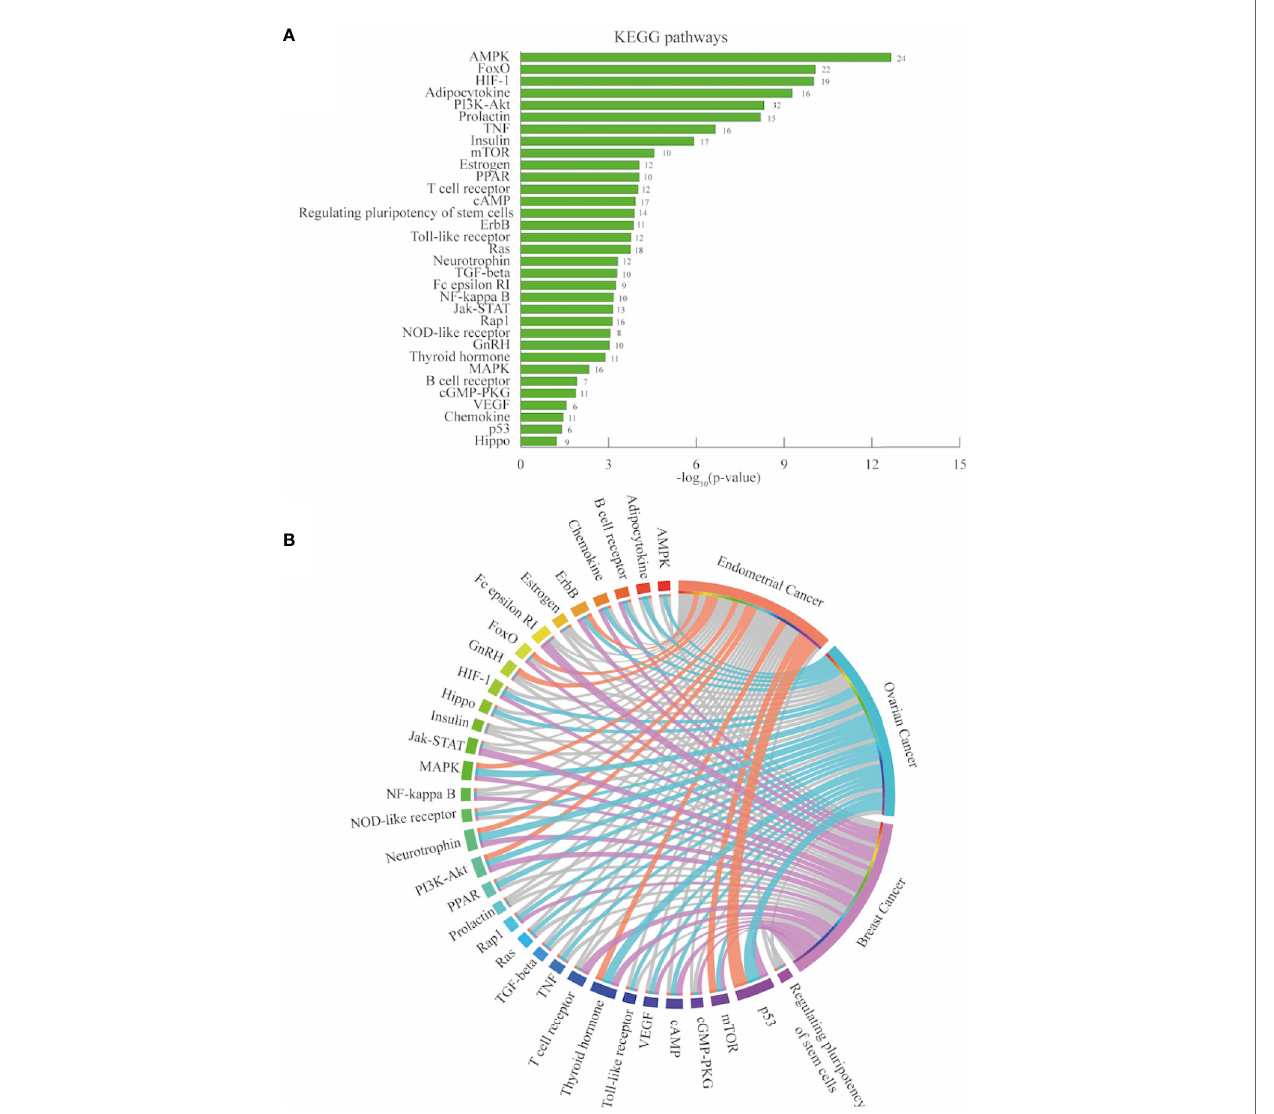
FIGURE 4 | Pathway enrichment analysis endometrial, ovarian and breast cancer. (A) Signi fi cantly enriched KEGG pathways of associated PCOS related genes (PRG [n=264]) retrieved from DAVID bioinformatics platform. The number in each bar are the gene count per pathways. (B) Circos plot depicting the most altered pathways ( fi rst quartile colored in each cancer